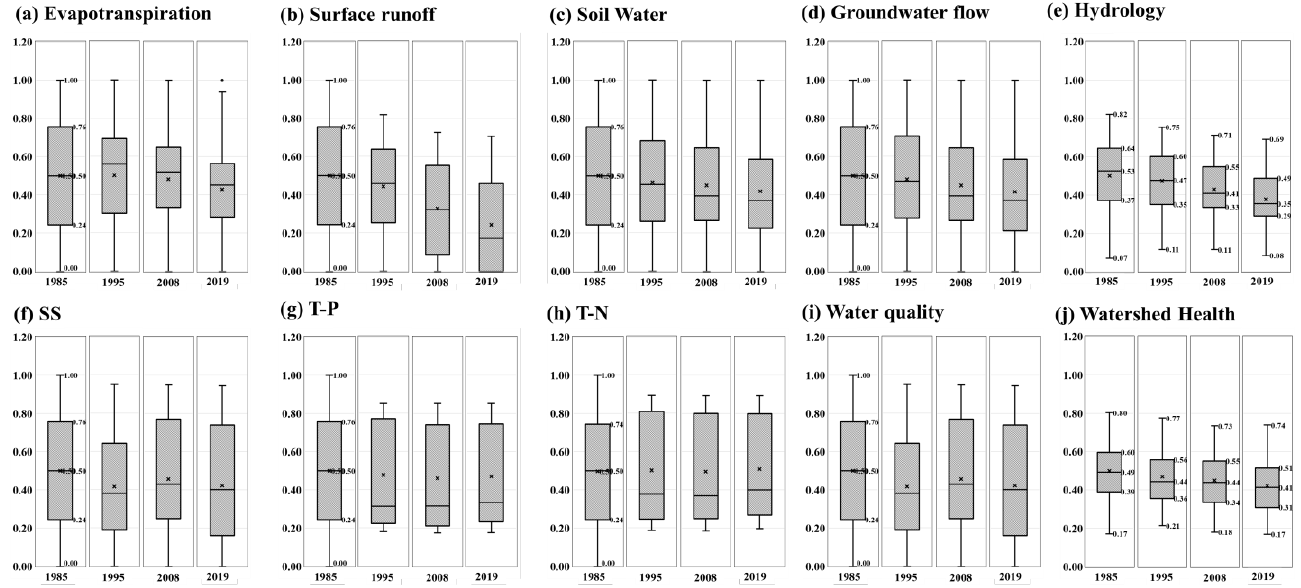
Figure 6. Boxplot of each component of WHI in Geum River Basin.